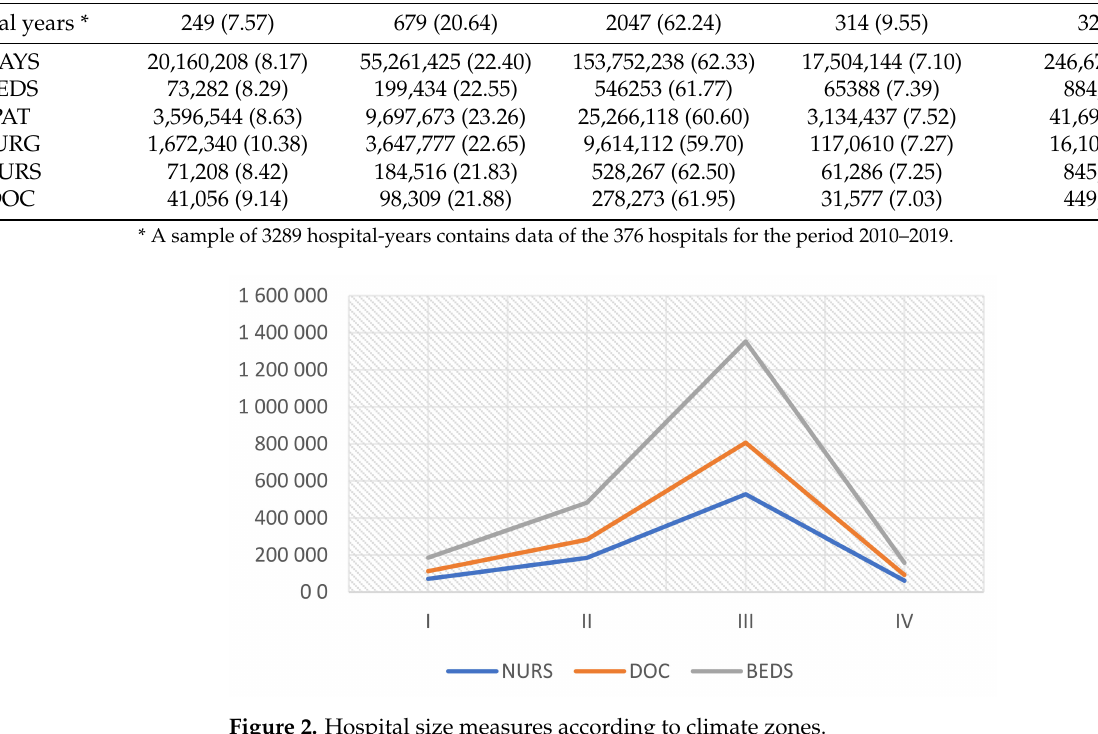
Figure 2. Hospital size measures according to climate zones.